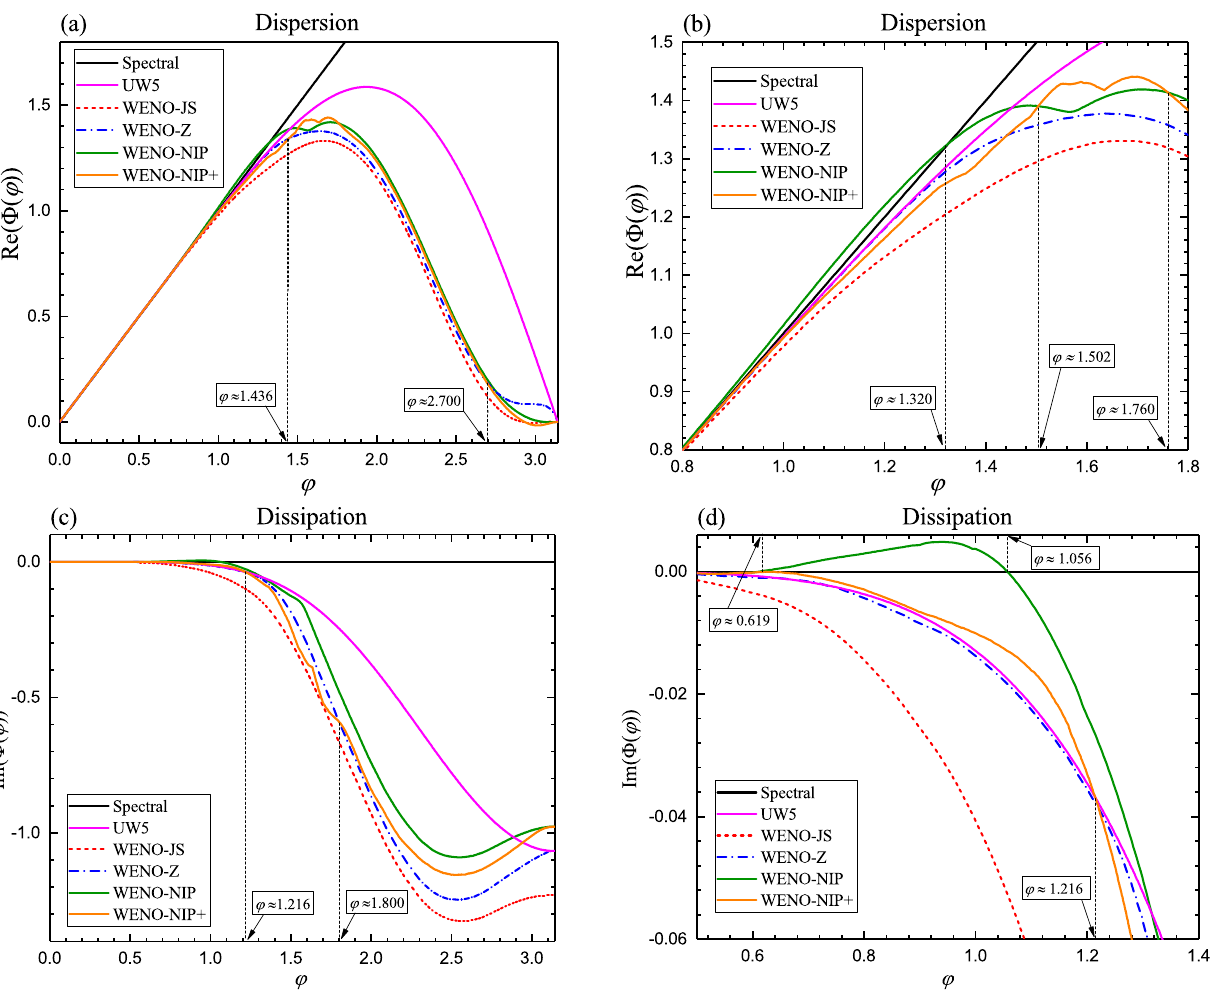
Figure 2. ( a ) Comparison of the dispersion properties of different schemes. ( b ) Zoomed-in view of ( a ). ( c ) Comparison of the dissipation properties of different schemes. ( d ) Zoomed-in view of ( c